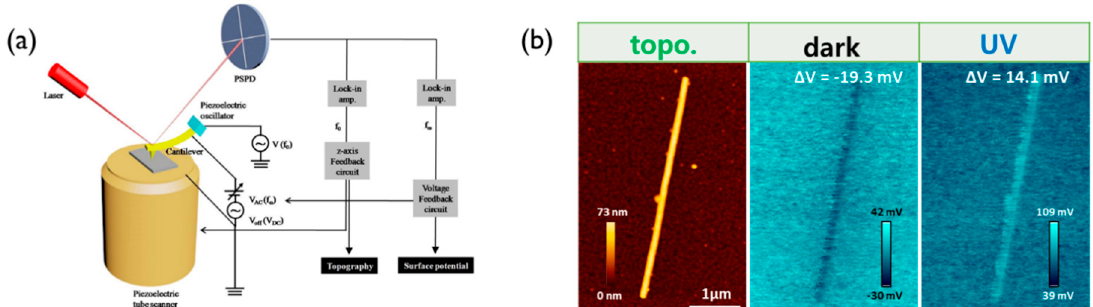
Figure 13. ( a ) Operation mechanism of Kelvin probe force microscopy (KPFM). ( b ) The representative surface potential images of an Au/TNT on a Pt substrate before and after ultraviolet (UV) illumination. Adapted from reference [112]. Copyright (2014) American Chemical Society.